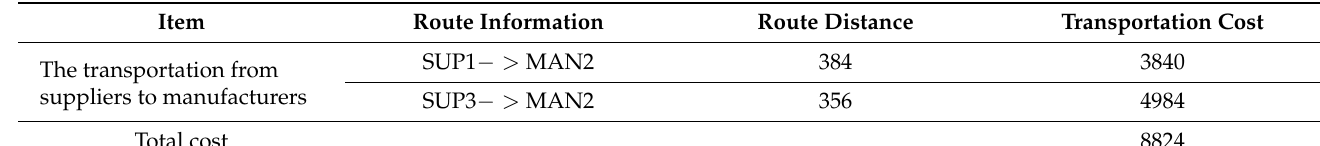
Table 11. The transportation from suppliers to manufacturers in the optimal solution of P01 by